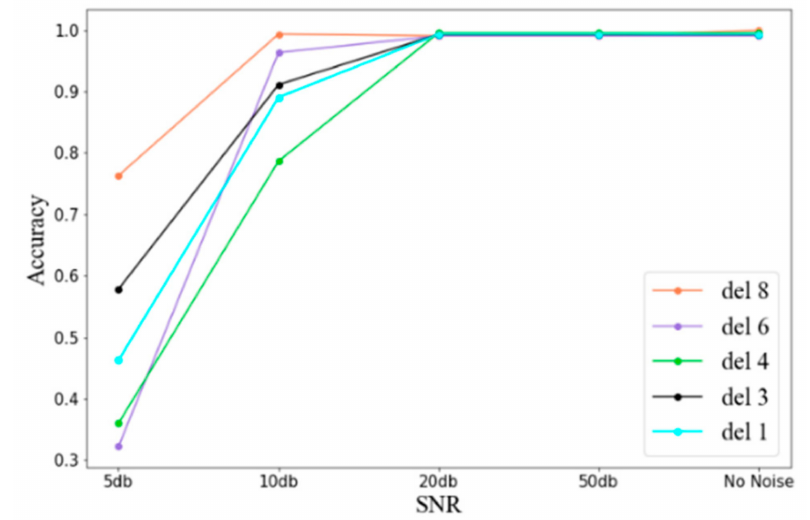
Figure 17. Comparison of the fusion diagnosis e ff ect of di ff erent measuring points when the number of measuring points is